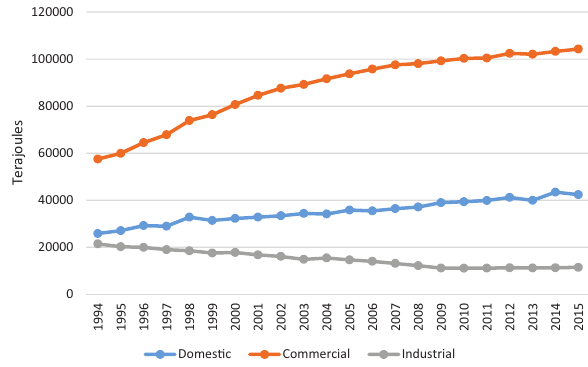
Figure 1. Sectoral breakdown of electricity consumption 1994- 2015 (sources: Census and Statistics Department, Hong Kong Energy Statistics-Annual Reports (various